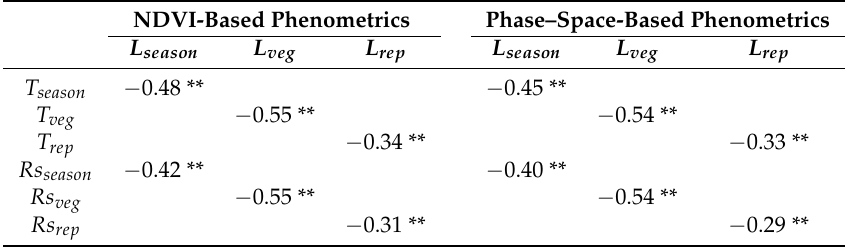
Table 3. Partial correlation coefficients between derived phenometrics and meteorological factors calculated based on the period of the corresponding phenometrics for all pixels in the four experimental sites during the period 2013–2017. ** p -value statistically significant at <0.001.